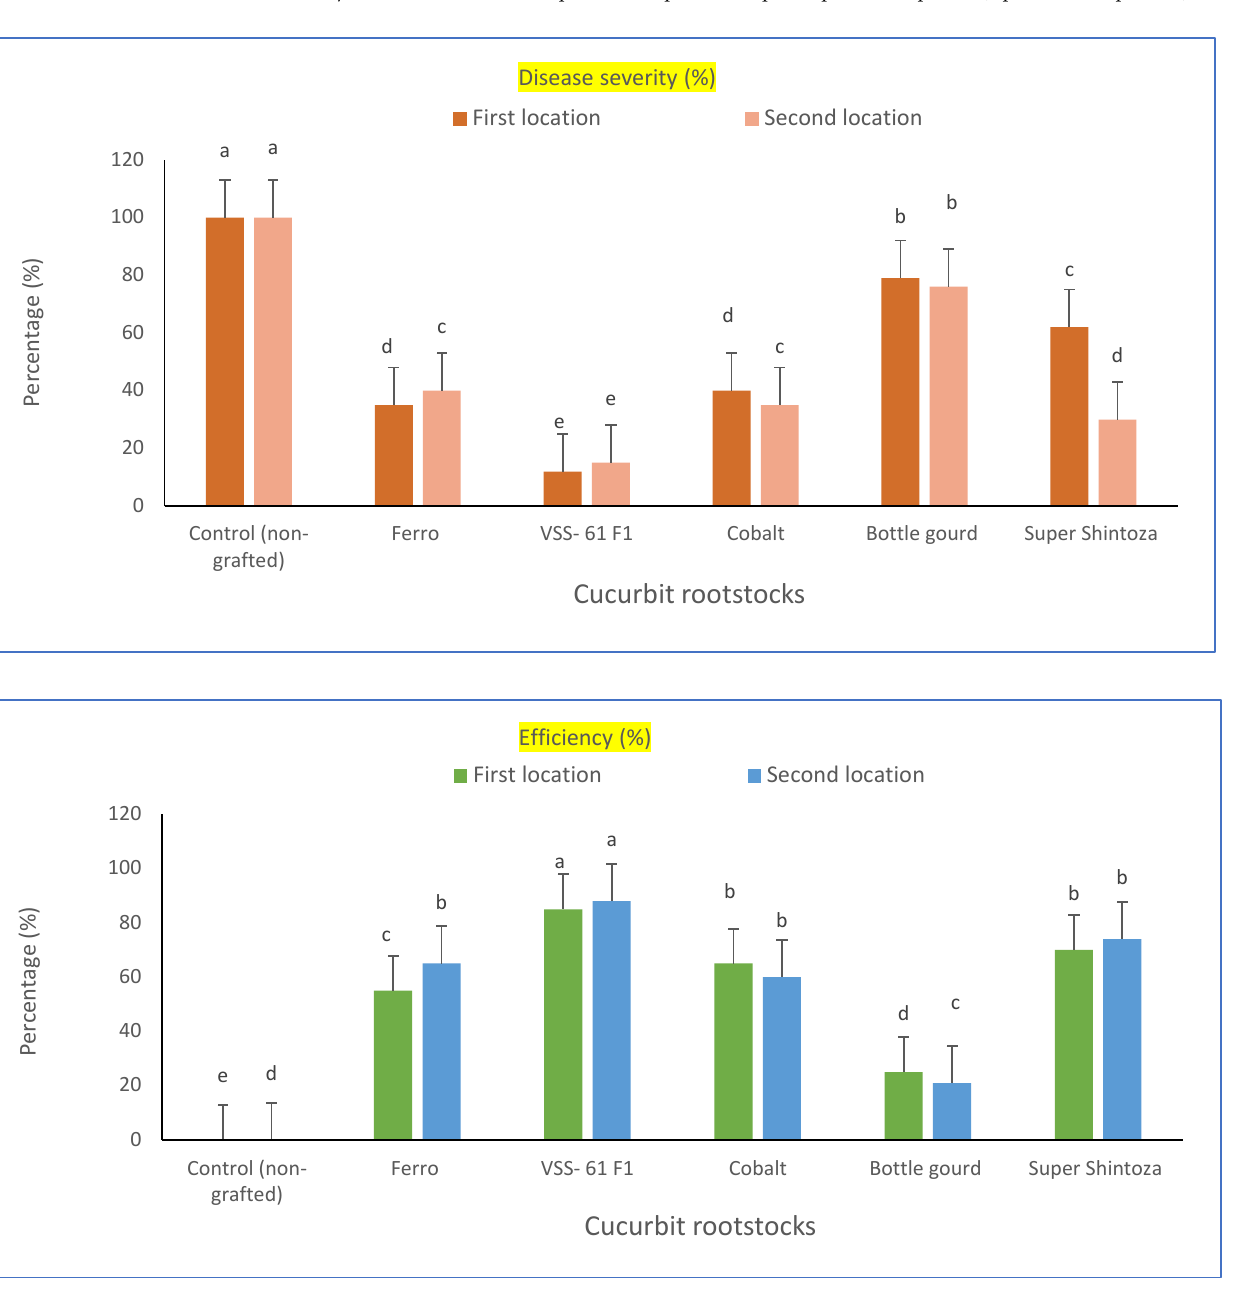
Table 1. Cont. Disease Incidence (%) Days after Transplanting Cucurbit Rootstocks 30 45 60 75 The signs ** and * indicate significant differences at p < 0.01 and p < 0.05, respectively, according to F-test F. test, Different letters in the same column show significant differences among each group of treatments according to Duncan’s test at p ≤ 0.05. Number of samples was 20 plants as 4 plants per each replicate (4 plants × 5 replicates).